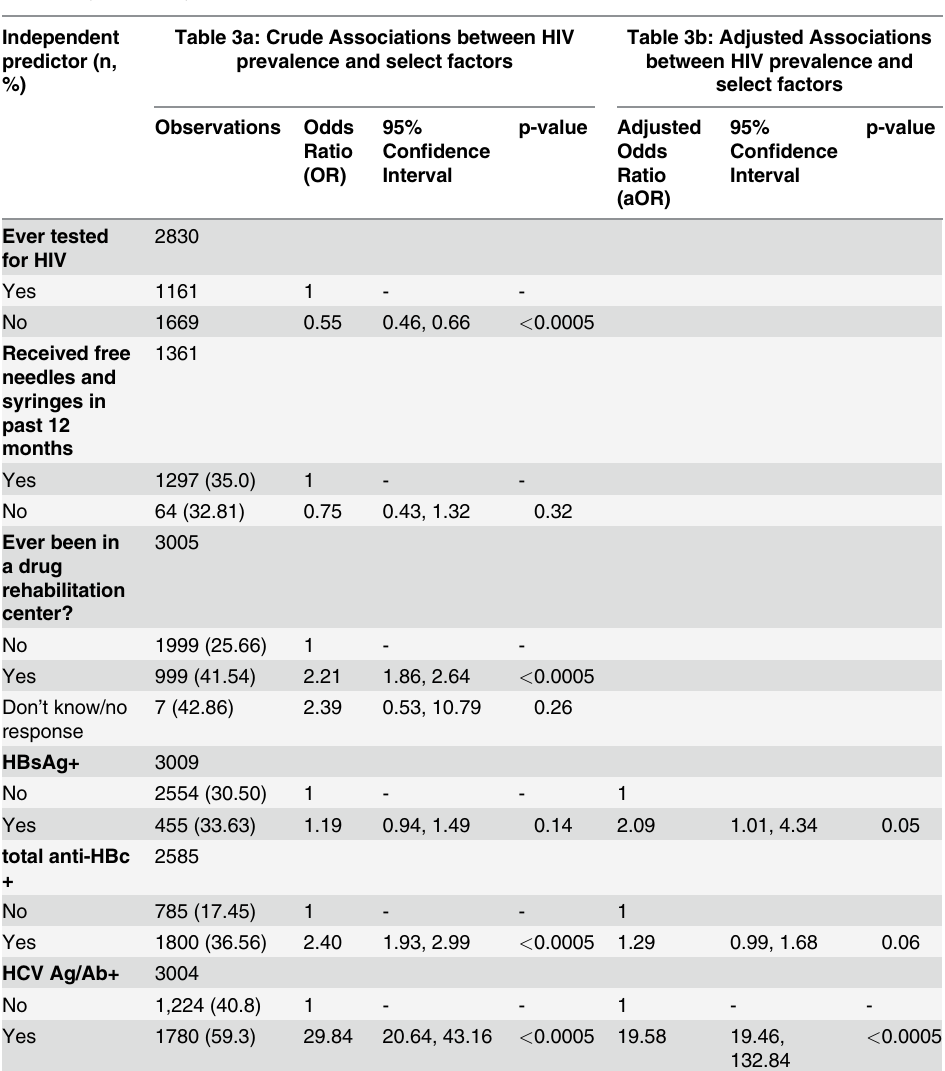
Table 3a: Crude Associations between HIV prevalence and select factors